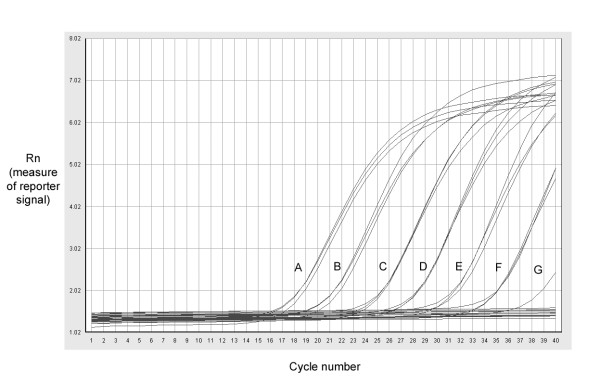
Sensitivity of PCR screening for XMRV in PBMC DNA. VP62 plasmid was serially diluted 1:10 into PBMC DNA from a healthy donor and tested by Taqman PCR with env 6173 primers and probe. The final amount of VP62 DNA in the reaction was A, 2.3 × 10-2 ng, B, 2.3 × 10-3 ng, C, 2.3 × 10-4 ng, D, 2.3 × 10-5 ng, E, 2.3 × 10-6 ng, F, 2.3 × 10-7 ng or G, 2.3 × 10-8 ng. The limit of sensitivity was 2.3 × 10-7 ng (shown by trace F) which equates to 16 molecules of VP62 XMRV clone.